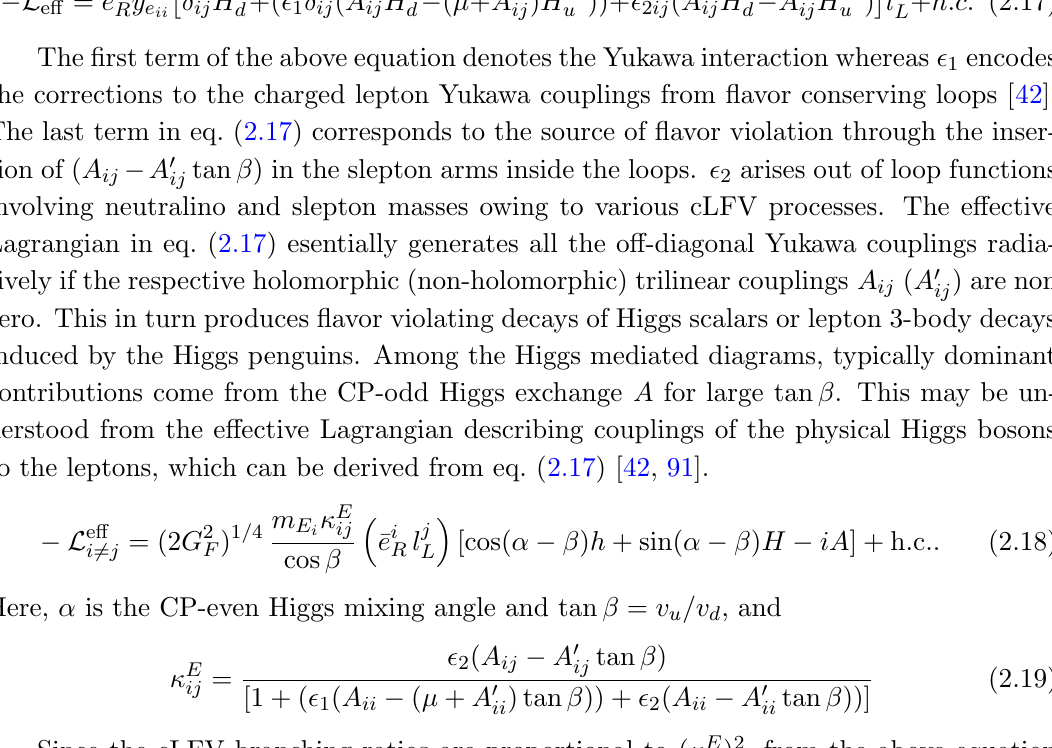
Figure 3. One loop diagrams contributing to computation of Br ( (cid:30) l i (cid:22) l j ) with LR & RL mixing. ! between neutral Higgs boson and charged leptons is given by [42, 91], (cid:2) (cid:3) = (cid:22) e i y (cid:14) H 0 +( (cid:15) (cid:14) ( A H 0 ( (cid:22) + A 0 ) H 0 (cid:3) ))+ (cid:15) ( A H 0 A 0 H 0 (cid:3) ) l j + h:c: e ii ij 1 ij ij 2 ij ij e(cid:11) R ij u ij u d d (cid:0) d (cid:0) L (cid:0)L